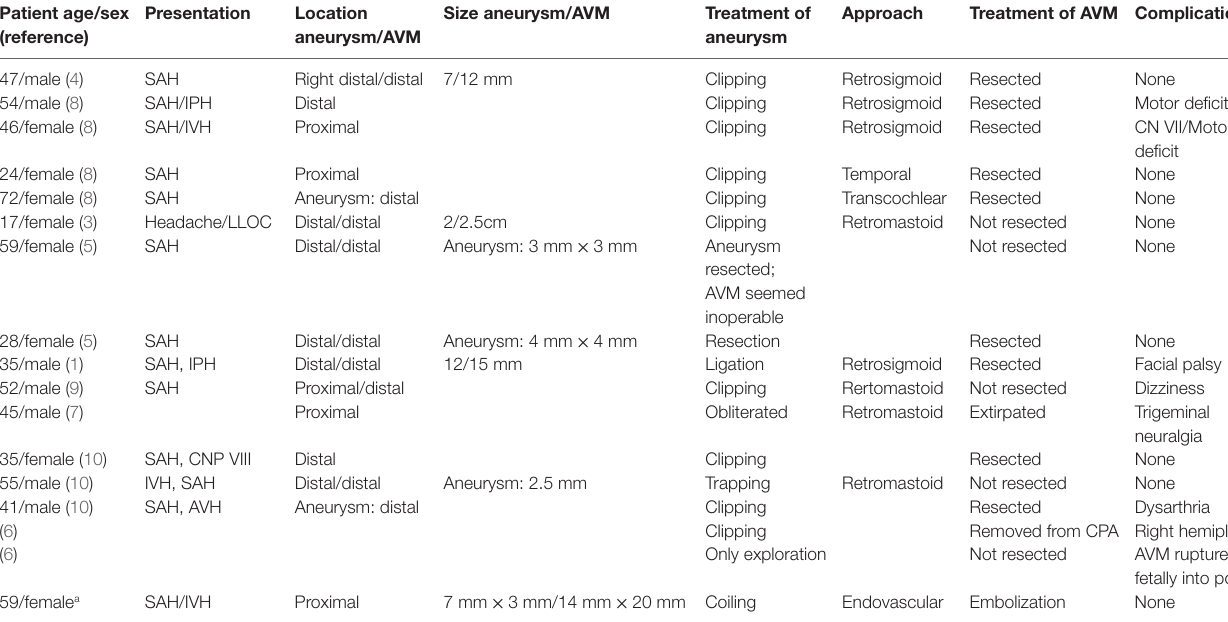
taBLe 1 | Summary of previously reported cases with AICA aneurysm and